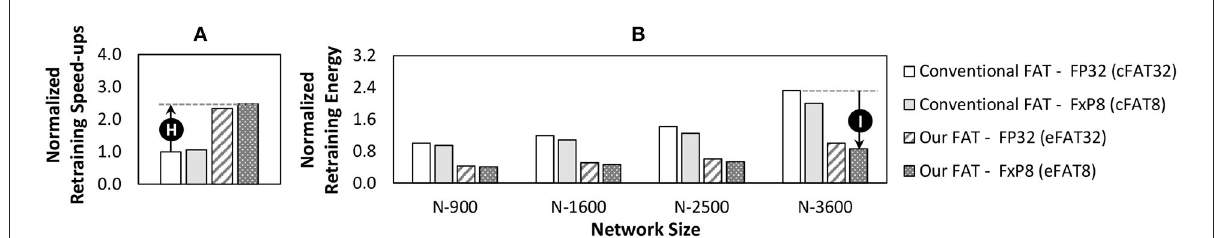
FIGURE15 (A) The retraining speed-ups across different network sizes (i.e., N-900, N-1600, N-2500, and N-3600), and (B) the retraining energy for the MNIST, which are normalized to the conventional FAT with FP32 for a 900-neuron network. The results for the Fashion MNIST show similar trends to the MNIST since these workloads have similar DRAM access latency and energy due to the same number of weights and number of DRAM accesses for a training phase. Here, FxP8 represents both the “signed Q 1.6 ” and “unsigned Q 1.7 ”